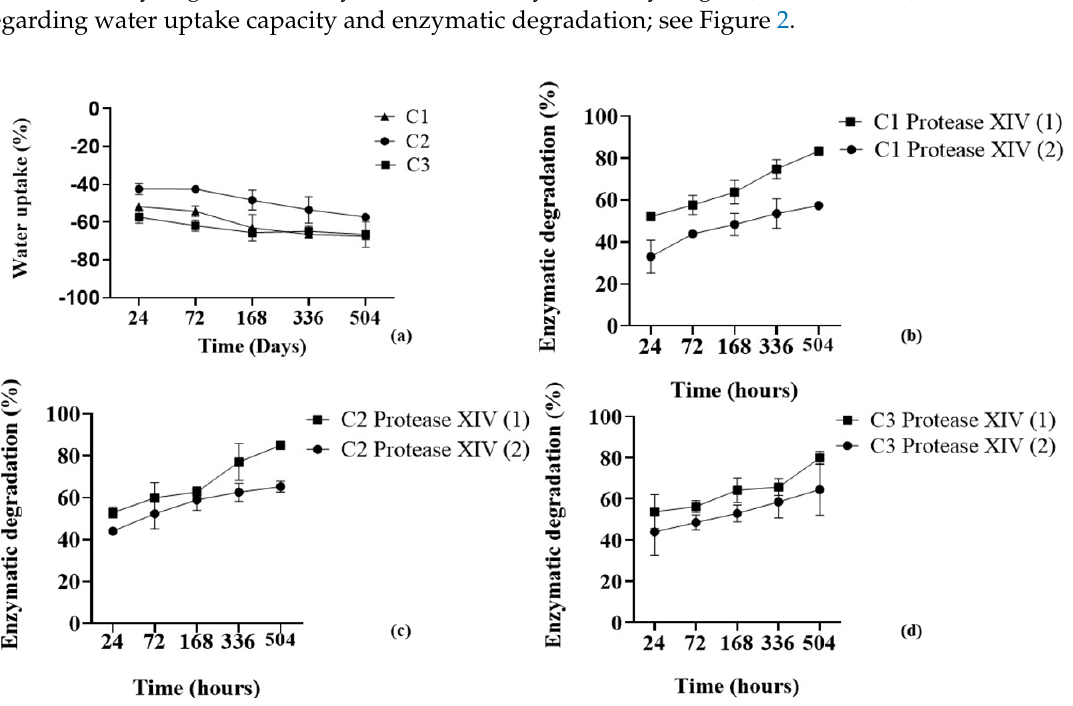
Figure 2. Water uptake ( a ) and enzymatic degradation profiles of C1 ( b ), C2 ( c ) and C3 ( d ) with Protease XIV at 3.3 U mL − 1 (1) and 1 U mL − 1 (2) and after 24, 72, 168, 336 and 504 h.